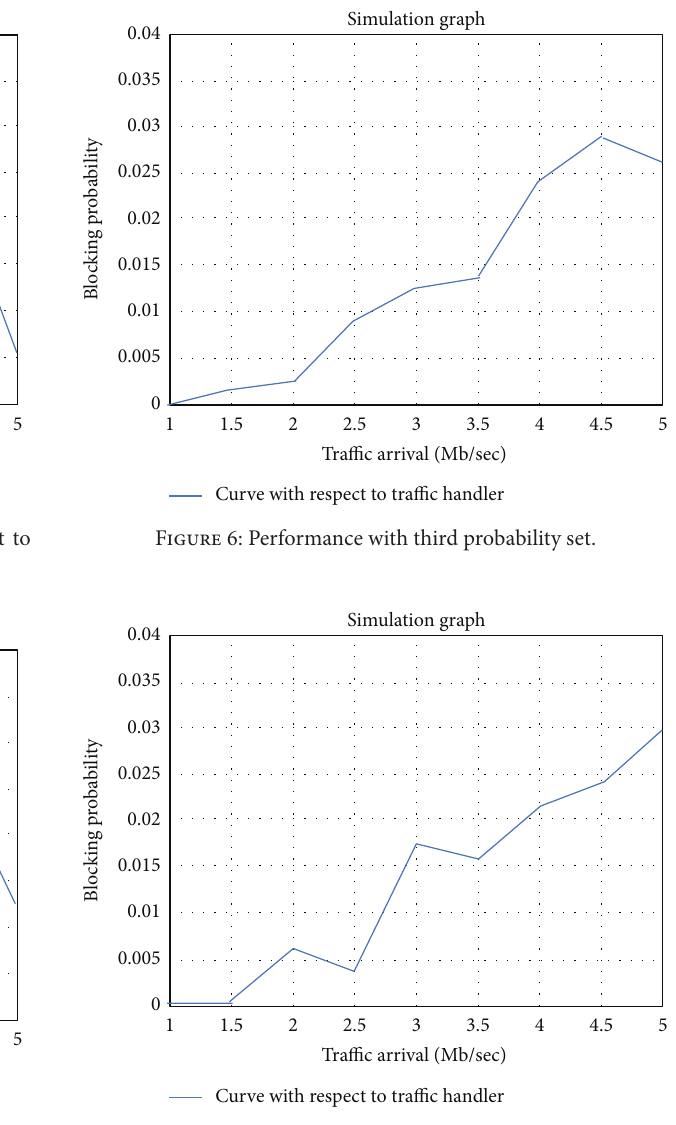
Figure 7: Performance with fourth probability